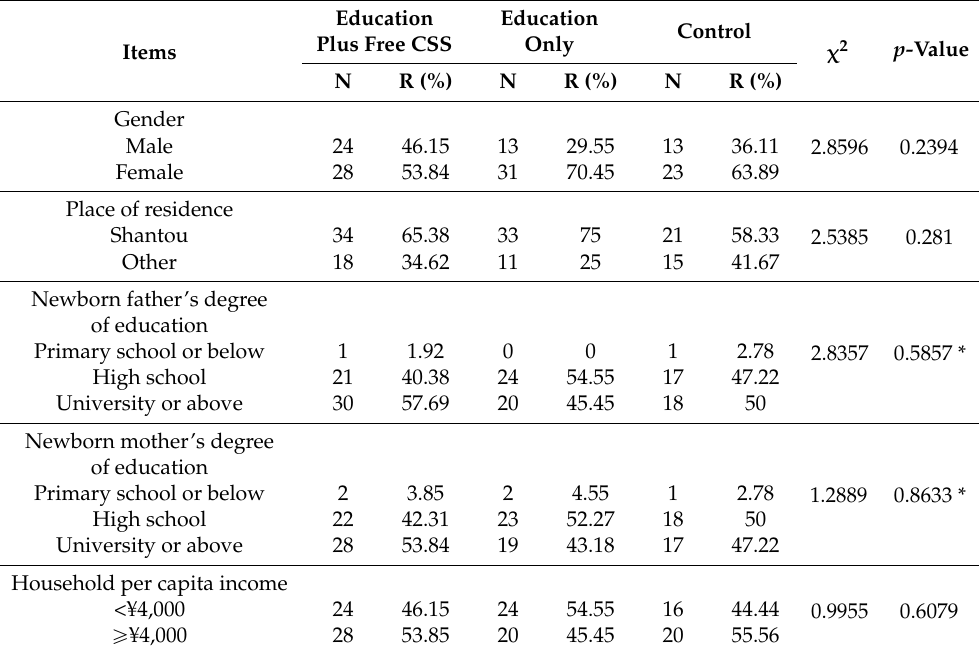
Table 1. Demographic characteristics of surveyed newborn parents among three groups.